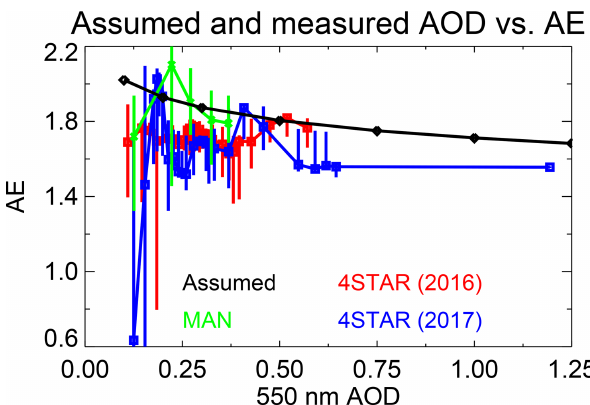
Figure 11. AE (470–870nm) assumed in the retrieval as a function of the AOD at 550nm (black), together with airborne 4STAR data from the 2016 (red) and 2017 (blue) ORACLES deployments, as well as the estimated smoke component (see text) of MAN cruises in the region (green). For the 4STAR and MAN data, points and lines indicate bin medians and the central 68% of data,